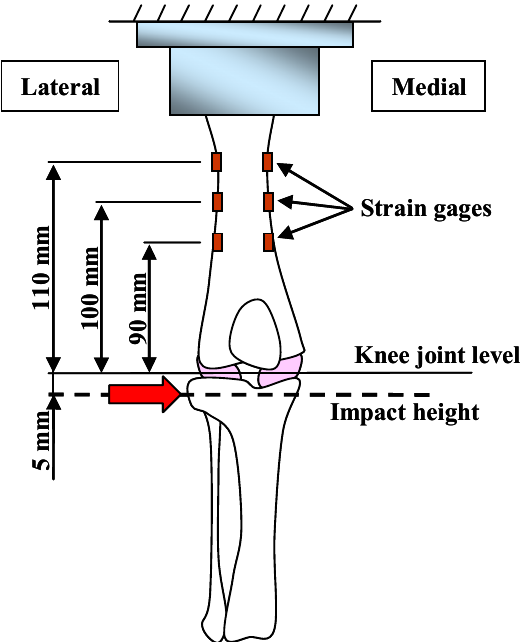
Fig. 2 Geometry of the specimen. Six strain gages were bonded to the femoral diaphysis at heights of 90, 100, and 110 mm above the knee joint level. The impactor struck the tibia 5 mm below the knee joint